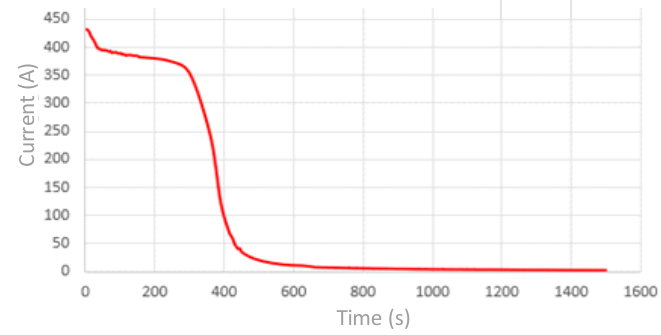
Figure 4. Time-waveform of short-circuit current during the experiment.